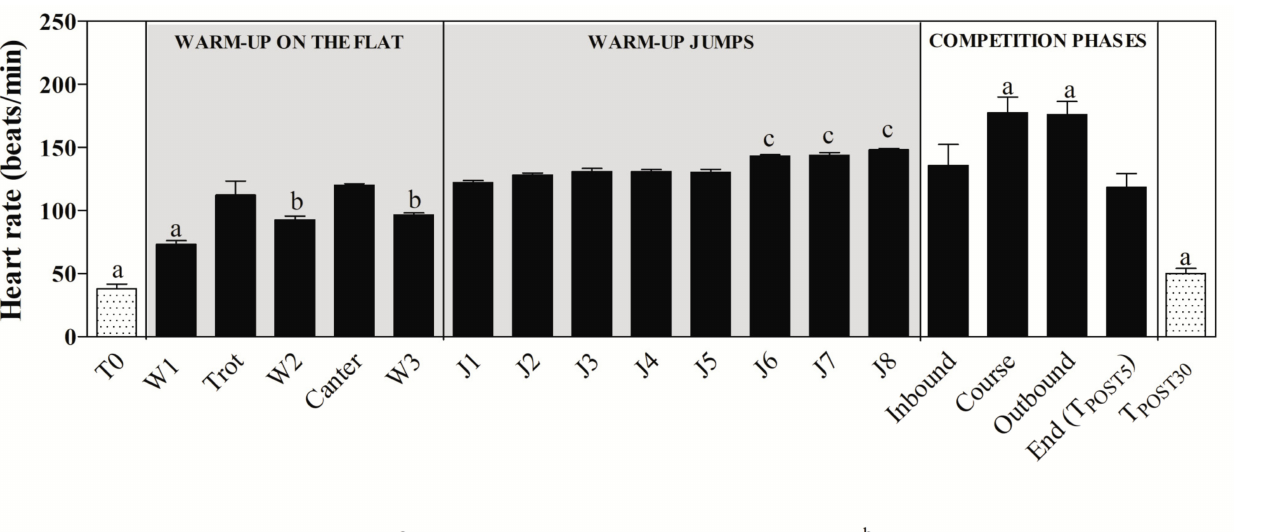
Figure 1. Heart rate values recorded from each horse during the warm-up and competition. The warm-up on the flat included a walk (W1–W3), trot, and canter section followed by 8 warm-up jumps (J1–J8). The competition in the show jumping arena included inbound (waiting time inside the arena before competing), course (time of the jumping phase), outbound (time lapse between the end of the course and the exit from the arena), and end (time lapse between the exit and the arrival to the